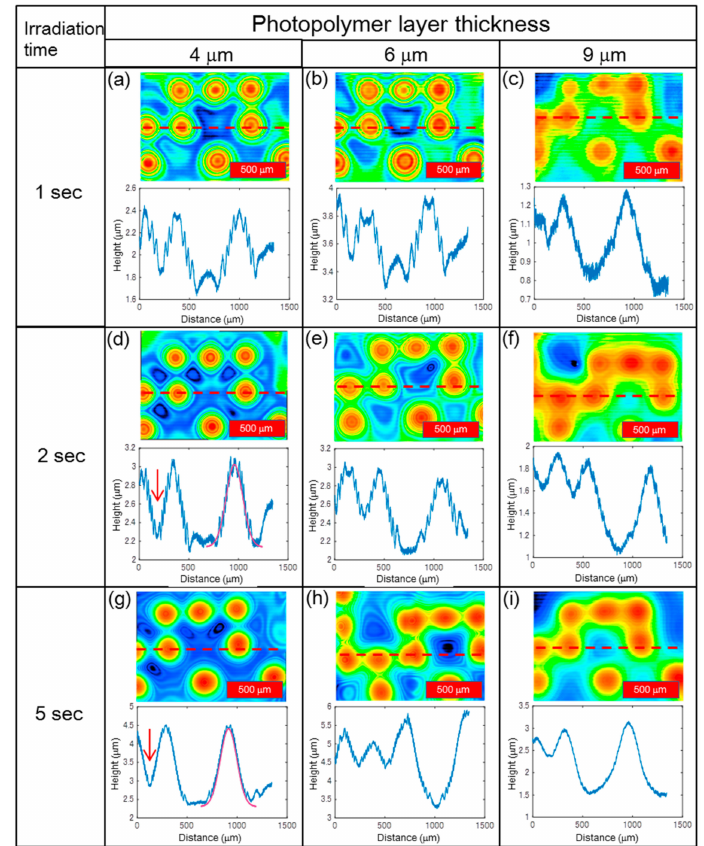
Figure 7. Two-dimensional surface volume changes and the cross-sectional distributions for Gaussian-like random phase masks under photopolymerization depending on both the photopolymer layer thickness and UV irradiation